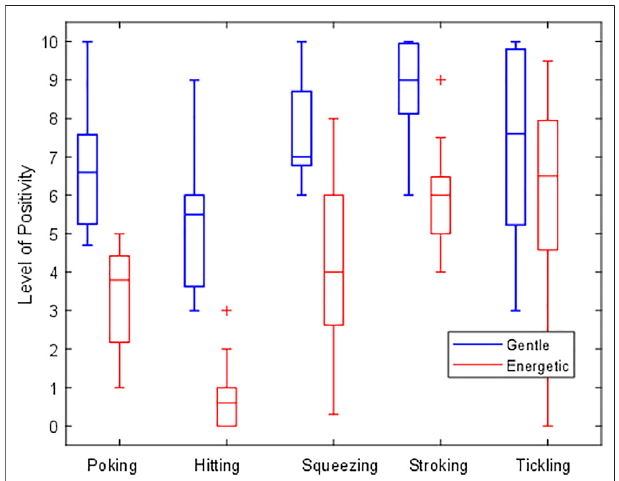
FIGURE 6 | A box-and-whisker plot comparing participants ’ level of agreement with seven questions before and after interacting with the robot. For each distribution, the central line indicates the median, the box shows the interquartilerange(IQR),thewhiskersshowtherangeupto1.5timesthe IQR, and + marks indicate outliers.